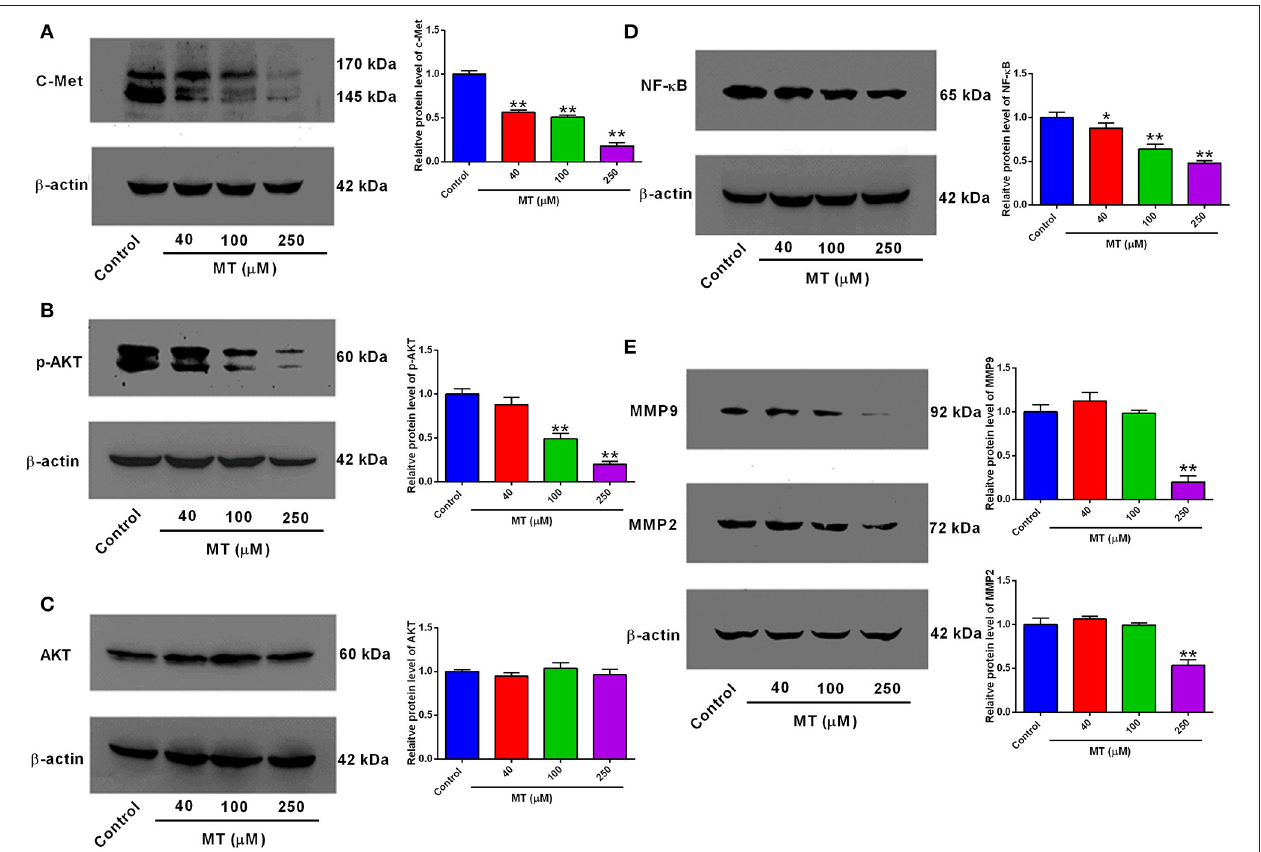
FIGURE 4 | Effects of MT treatment on the protein expression levels of c-Met, p-AKT, AKT, NF- κ B, MMP2, and MMP9 in HepG2 cells. (A) c-Met, (B) p-AKT, (C) AKT, (D) NF- κ B, (E) MMP9 and MMP2 in MT-treated HepG2 cells were assessed by Western Blot analysis and were quantified using ImageJ software. Data from at least three independent experiments performed in triplicates are presented; * P < 0.05 and ** P < 0.01 compared to the corresponding control